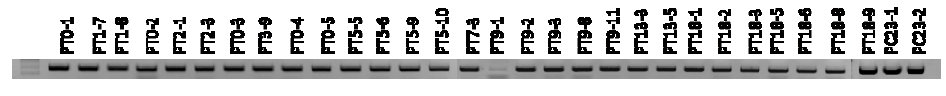
Figure 5. PCR detection of multi-copper oxidase gene (sufI).